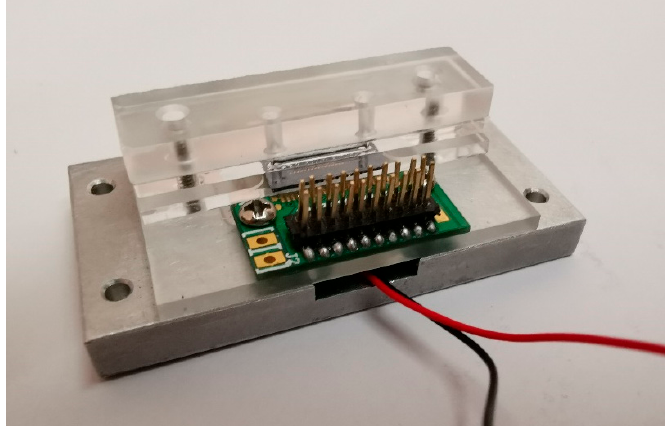
Figure 5. The microfluidic system.